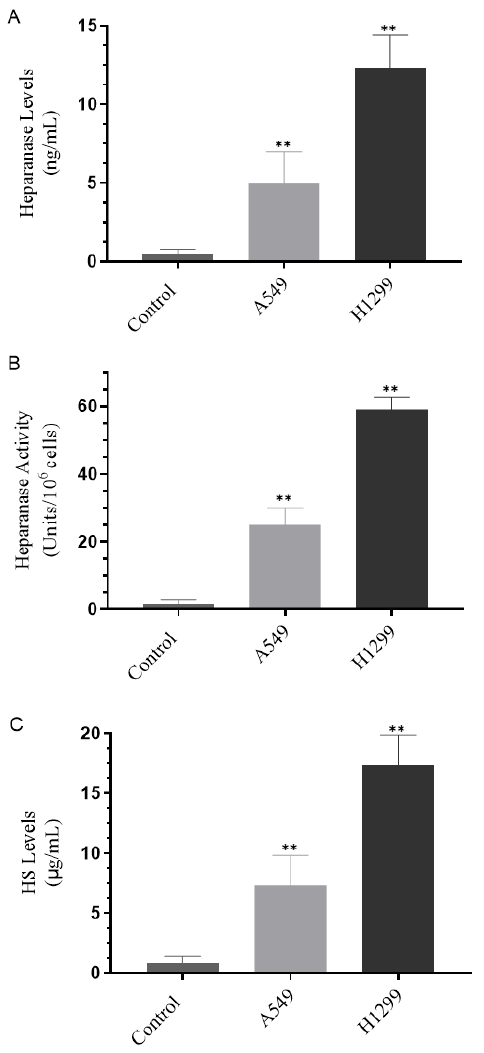
Figure 1. Higher heparanase levels and activity and higher levels of HS are found in H1299 cell media than in the media of A549 cells. Cells (0.2 × 10 5 ) were grown in 10% FBS-supplemented media for 24 h then serum-starved overnight. The cell monolayers were then incubated in serum-free media for 72 h then the levels of heparanase ( A ) and activity ( B ) along with the levels of HS ( C ) were measured as described in the Materials and Methods section. Data were processed using the GraphPad Prism 9.4.1 software and presented as the mean ± S.D. of three independent assays, each performed in triplicate. Asterisks indicate a statistically significant difference from the control using media not incubated with cells. Mann–Whitney test, ** p < 0.01.